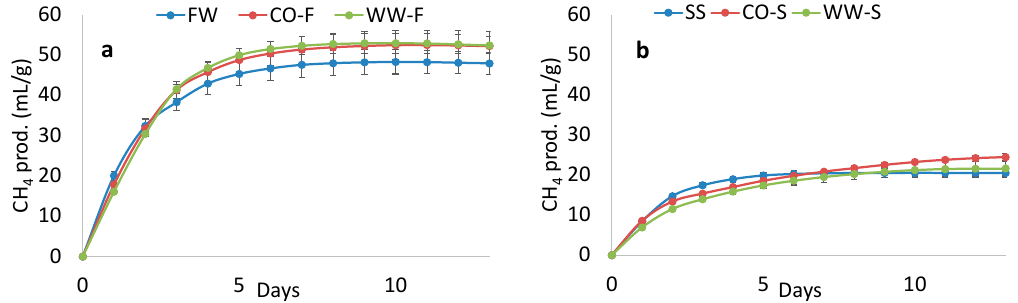
Figure 8. Volumetric bio-methane production from ( a ) food waste (FW) and hydrolysate from reactors CO-F and WW-F, and ( b ) sewage sludge (SS) and hydrolysate from reactors CO-S and WW-S. Error bars indicate the calculated standard deviation for daily values.